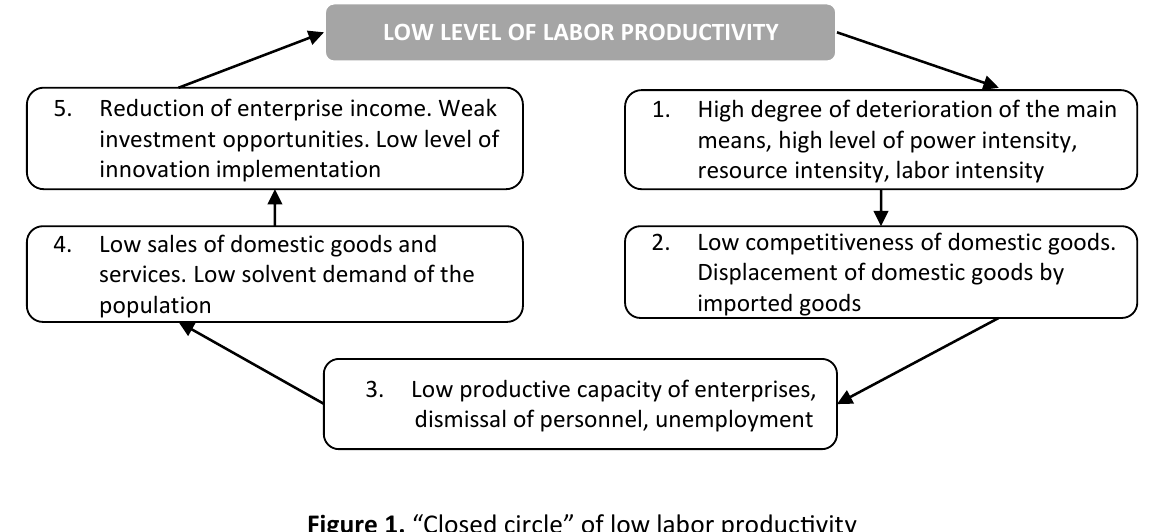
Figure 1. “Closed circle” of low labor